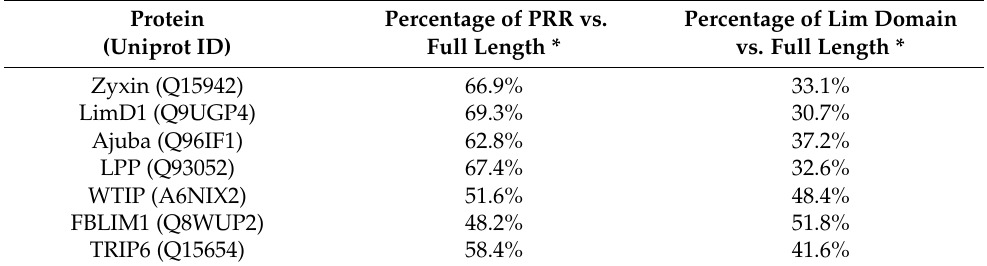
Table 2. Percentage composition of Proline Rich Region (PRR) and LIM domain in the full-length proteins. Protein Percentage of PRR (Uniprot ID)